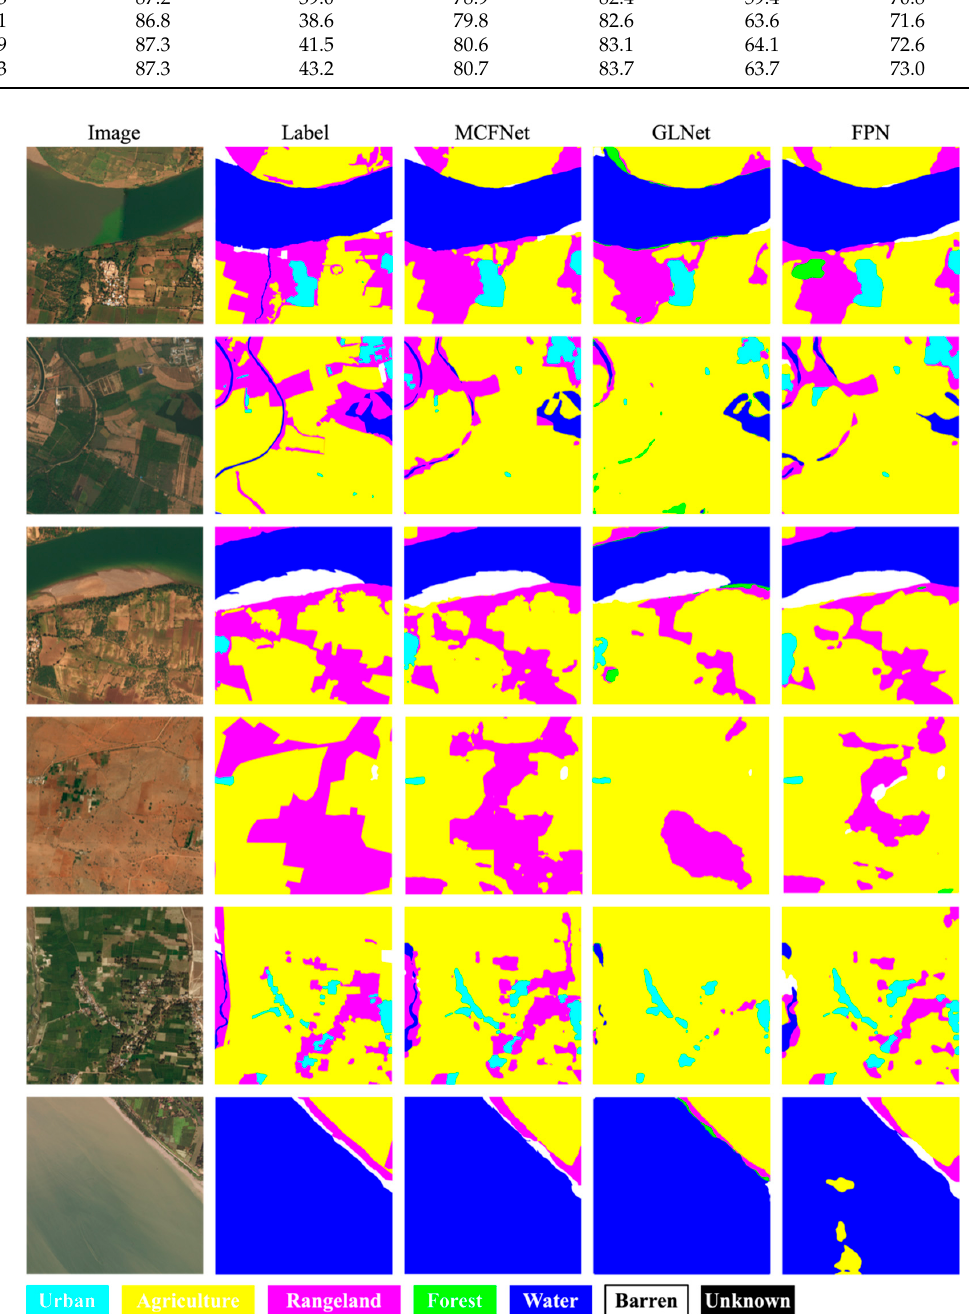
Figure 7. Visual comparison of semantic segmentation results on the DeepGlobe.